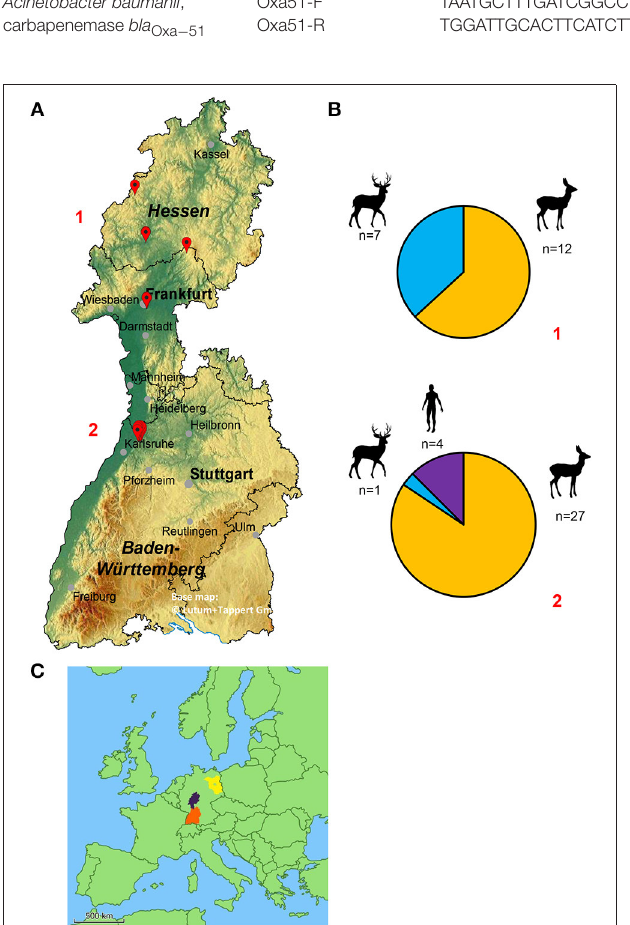
FIGURE 2 | (A) Geographical map of the federal states of Hesse and Baden-Wuerttemberg (Germany) displaying the locations of deer ked collections. The red marks represent the location where deer keds were collected (from top to bottom, numbers in red: 1 = Hesse, 2 = Baden-Wuerttemberg). Four deer ked flies, which are not displayed, were collected in the greater area of Wittstock located in the federal state of Brandenburg (Germany). The base map was generated using EasyMap 11.0 © Lutum+Tappert DV-Beratung GmbH. (B) Distribution of sampled deer keds and their hosts in relation to their location. 1: Hesse, 2: Baden-Wuerttemberg (C) Map of Europe. The exact locations of Hesse (purple), Baden-Wuerttemberg (orange) and Brandenburg (blue) are tagged.